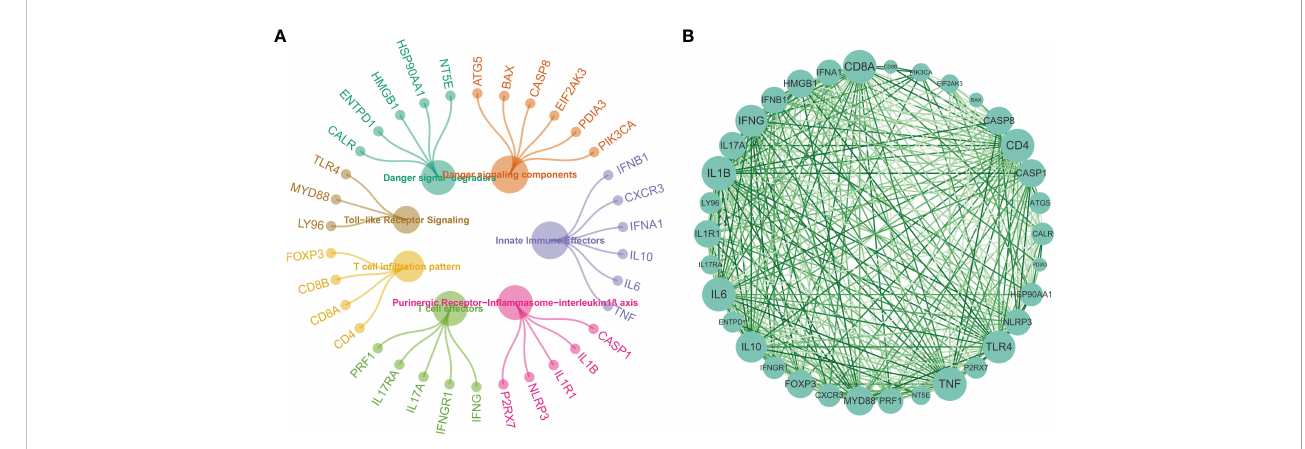
FIGURE 1 (A, B) Protein-protein interactions among the